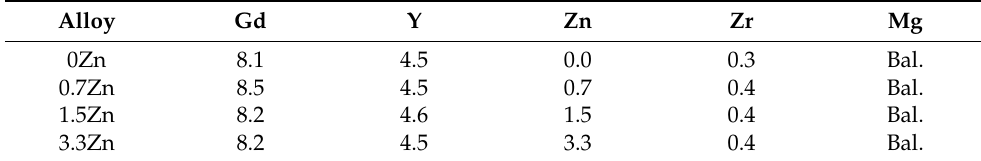
Table 1. Actual chemical compositions of the experimental alloys (wt.%). Alloy Gd